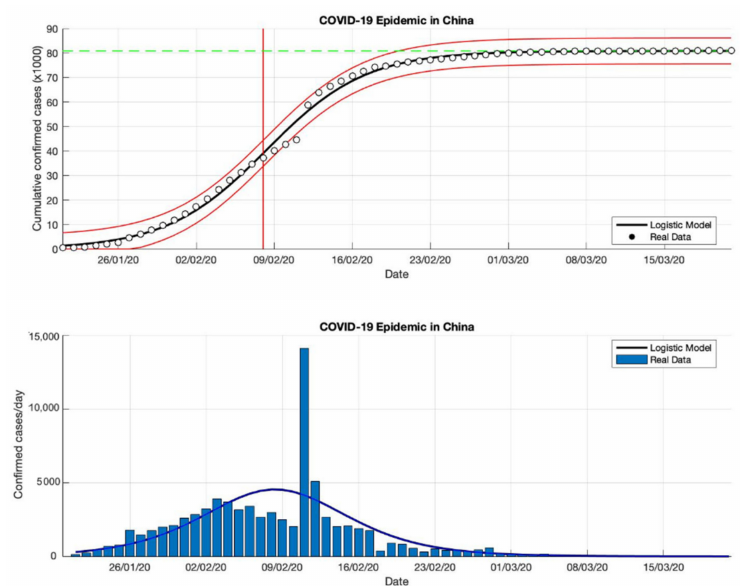
Figure 2. In the above figure, the prediction results of the logistic growth model for cumulative infected cases are compared with the actual data, while the two red lines between the black lines represent a prediction error limit of about 5%. The dashed green line predicts the total size of infected cases in the final phase of the epidemic. The red line intersects the cumulative case curve to predict the turning point or peak point of the epidemic (this line is parallel to the top of the curve from the below figure). In the below figure, the prediction results of this model for daily infected cases in